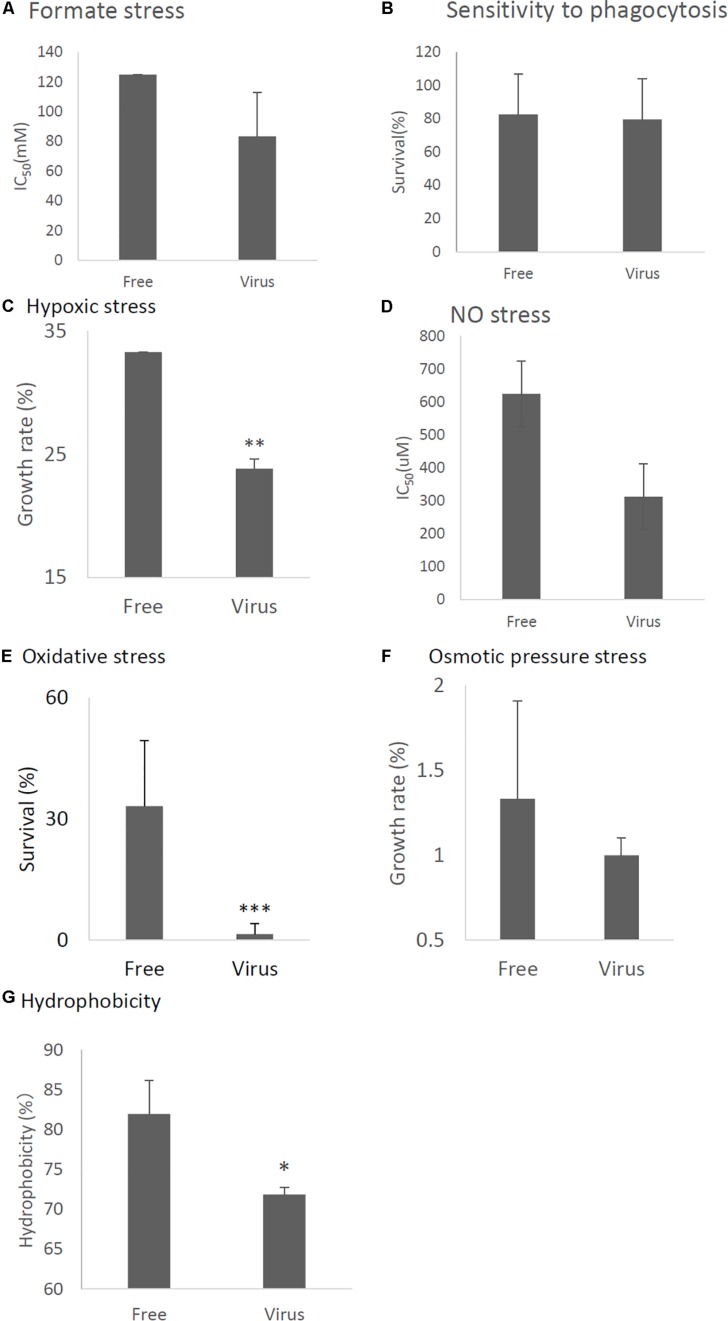
Comparisons of tolerance to stresses of virus-free (Free) and virus-infected (Virus) strains. (A) IC50 of the strains under formate stress conditions (RPMI 1640 medium). (B) Sensitivity of the A. fumigatus strains to phagocytosis by J774A.1, a murine macrophage cell line. Techniques are described in the section “Materials and Methods.” (C) Effect of hypoxic stress (conidial growth under anaerobic culture conditions). Germination and growth rate are expressed as percentages of growth in the absence of stress. Experimental methods are detailed in the section “Materials and Methods.” (D) IC50 of the strains under NO stress conditions (NOC-18 in RPMI1640 medium). (E) Germination rates of the virus-free and virus-infected strains under oxidative stress (germination following 24-h exposure to 32.6 nM H2O2). (F) Growth of the virus-free and virus-infected A. fumigatus strains under osmotic stress conditions (conidial growth in the presence of 0.8 M NaCl). (G) Hydrophobicity. Data are presented as mean + SD of three independent experiments. ∗P < 0.05, ∗∗P < 0.01, ∗∗∗P < 0.001, by two-tailed Student’s t-test.